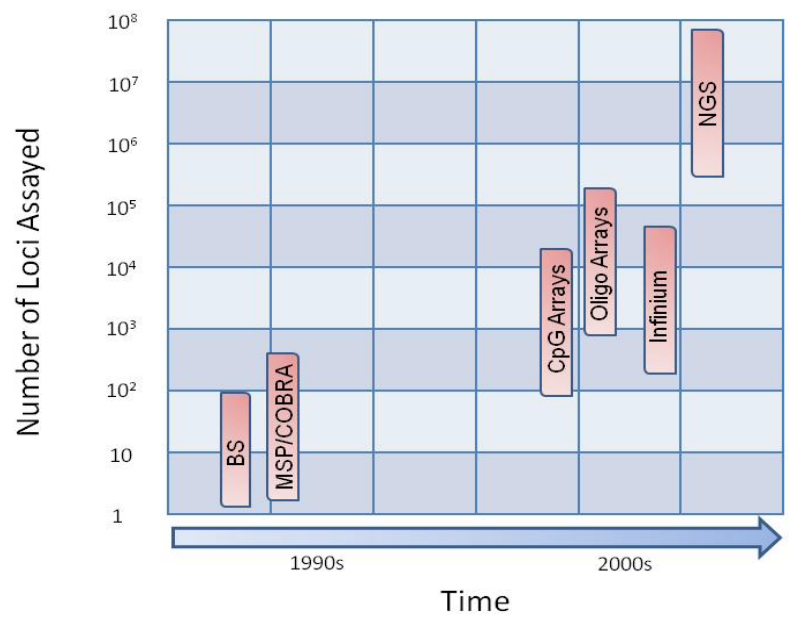
Figure 1. Time versus number of loci assayed. The number of loci assayed has increased over time with the development of new technologies. Bisulfite sequencing (BS), methylation specific PCR (MSP) and combined bisulfite restriction analysis (COBRA) were introduced in the 1990s. These methods provided methylation data for up to a few hundred genes in a single experiment. Methylation arrays were introduced in the 2000s and provide methylation data for up to 100s of thousands of loci. (N.B. The latest oligonucleotide array available from Nimblegen allows for the interrogation of more than two million loci). Next-generation sequencing (NGS) was introduced in 2007 and provides single base pair resolution for billions of